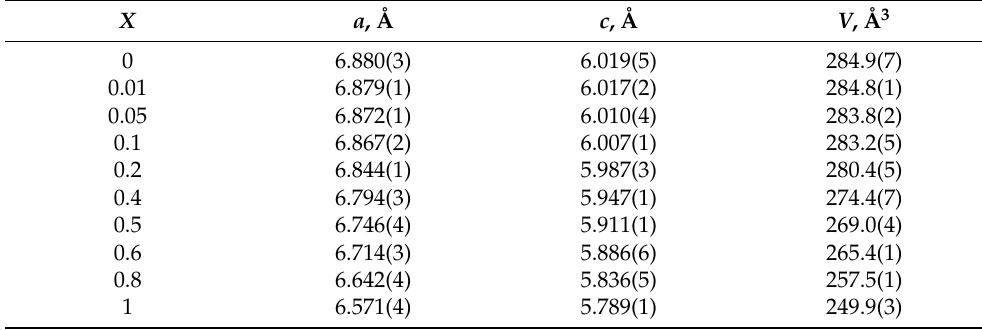
Table 1. Lattice parameters of Y 1 − x Sc x PO 4 .